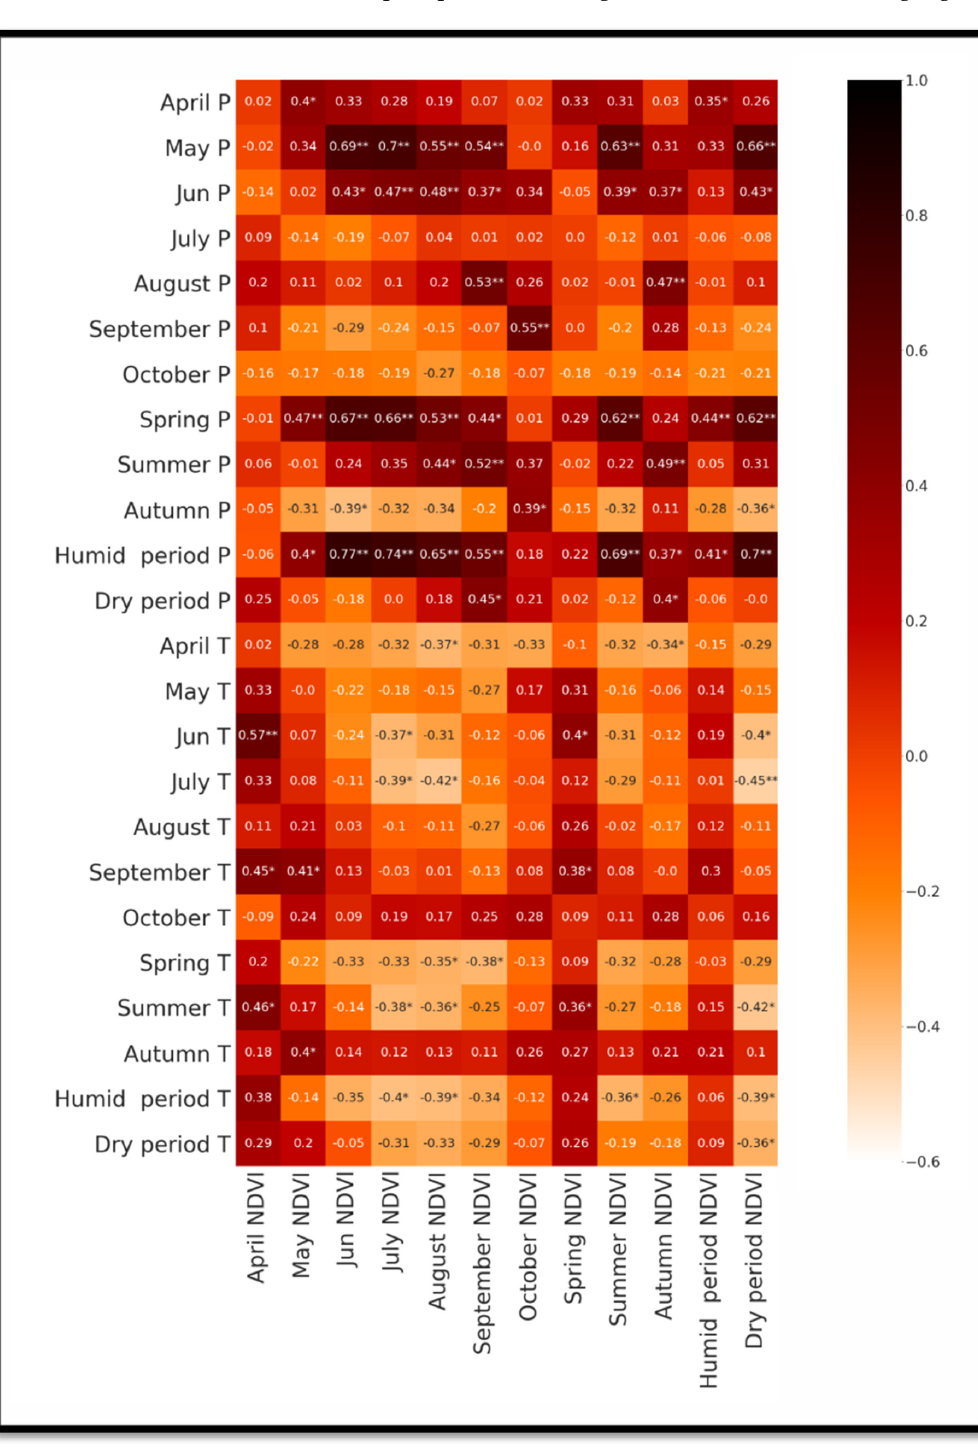
Figure 4. Correlation between averaged monthly and periodic values of temperature, precipitation, and BRDF NDVI for Meghri, with the levels of significance: * − p < 0.05, ** p < 0.01.